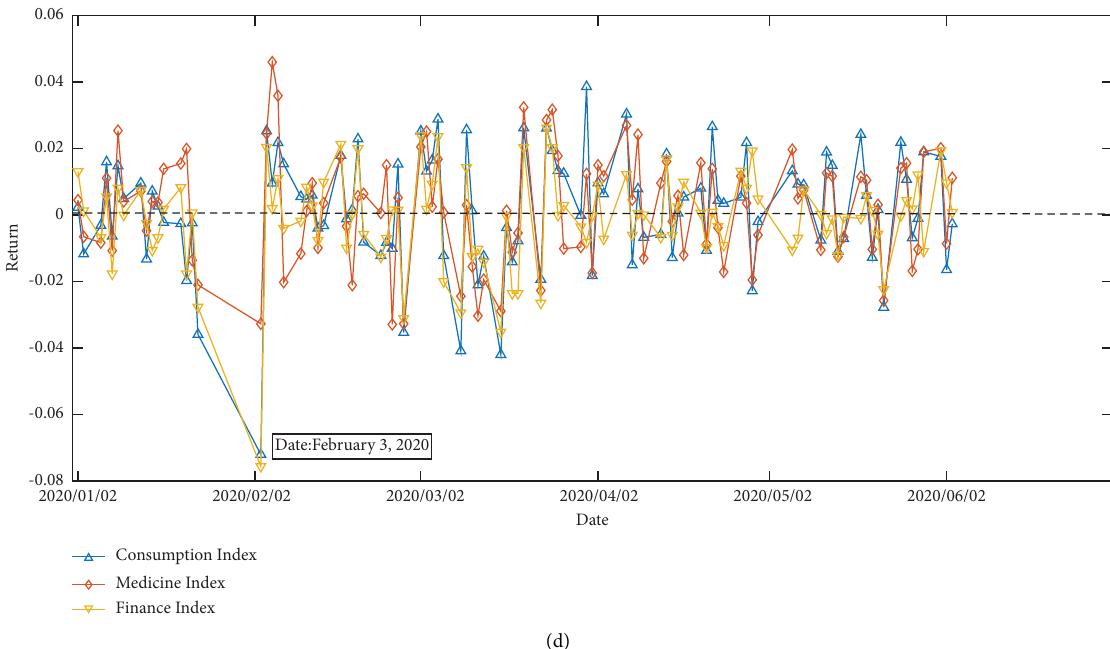
Figure 1: Sequence charts of daily returns of 98 stocks in the three major industries and the three major industry indices. (a) A daily return sequence chart of 30 stocks in the consumption industry, (b) a daily return sequence chart of 38 stocks in the pharmaceutical industry, (c) a daily return sequence chart of 30 stocks in the fnancial industry, (d) a daily return sequence chart of Shanghai consumption, Shanghai medicine, and Shanghai fnance.